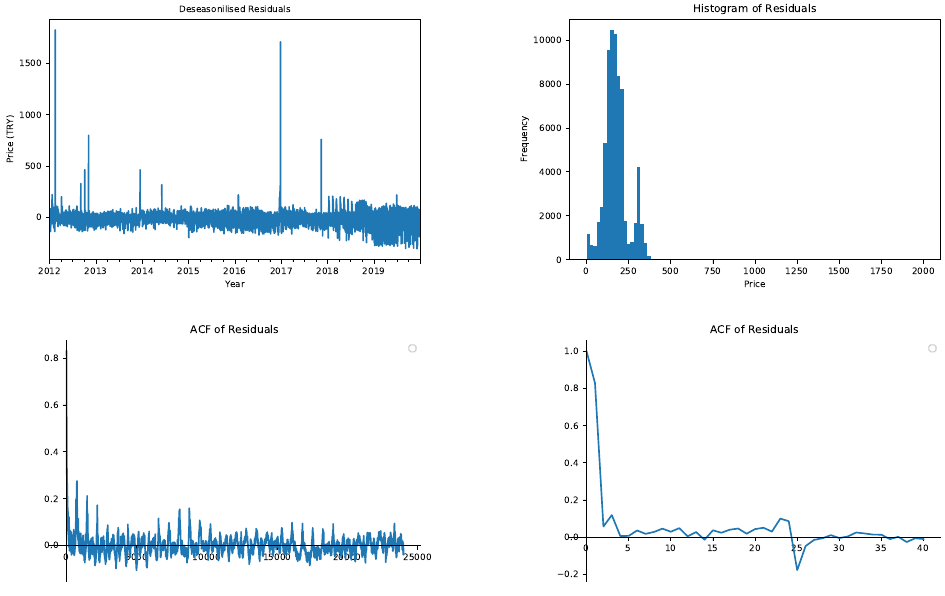
Figure 7. Time series, histogram, ACF and PACF of deseasonalised